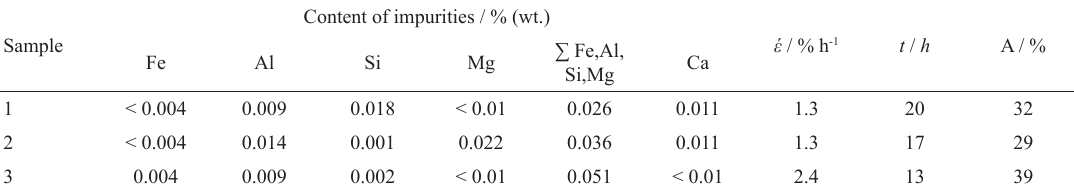
Table 4: The values of the creep rate, rupture time and relative elongation depending on the content of impurities at a temperature of 1400 °C, at a stress of 5 MPa, for the alloy PtRh5Pd15